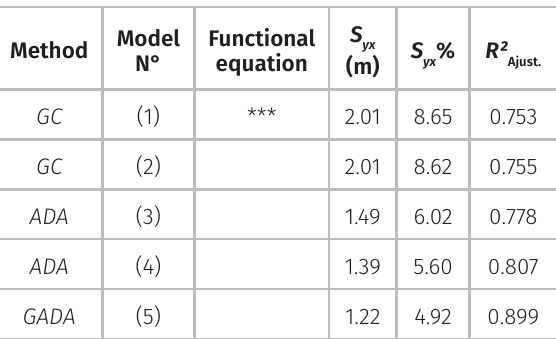
Table II. Coefficients and statistics of the models for forest sites classification of Eucalyptus sp. in a tropical region of